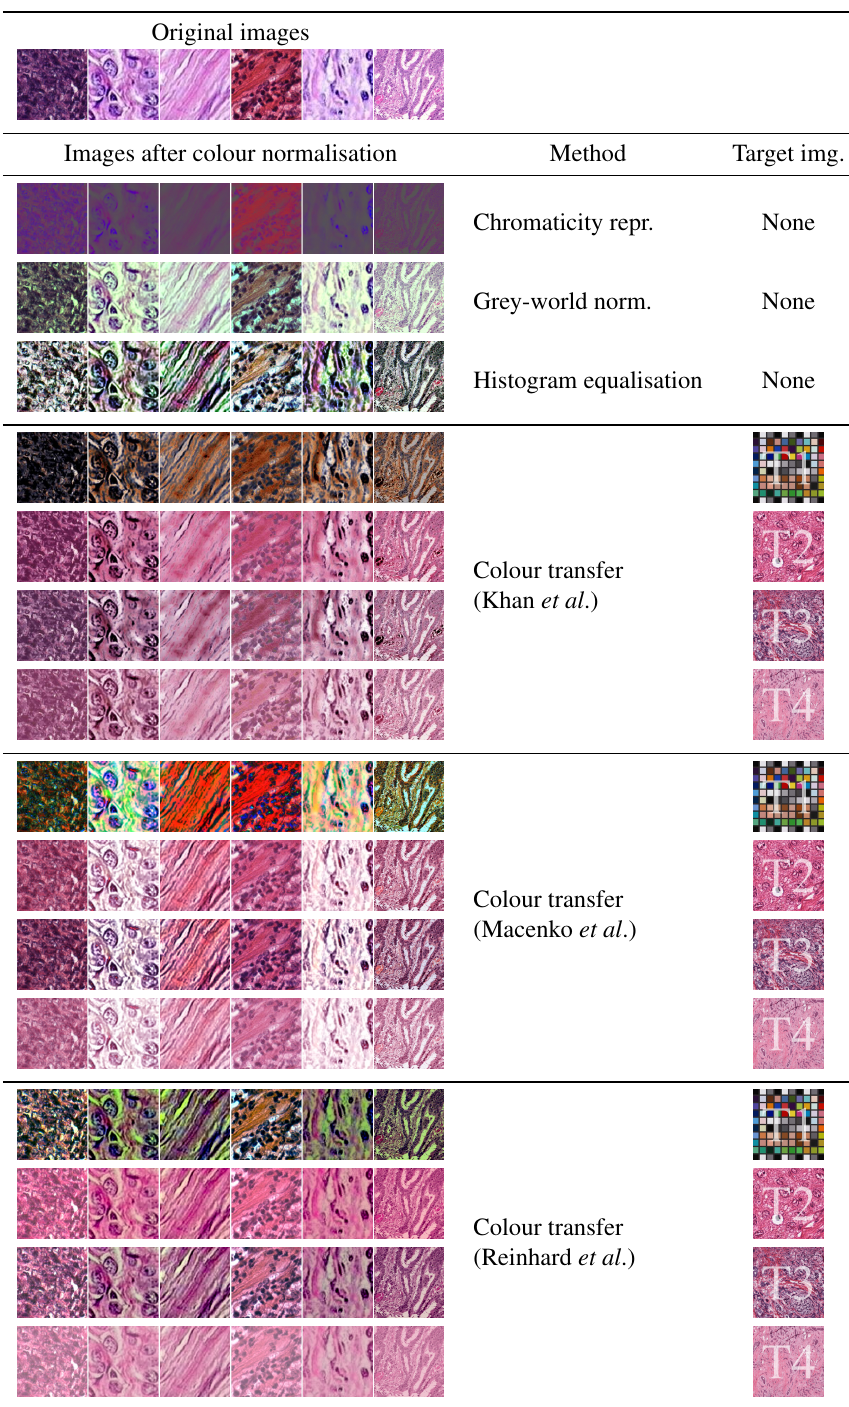
Figure 4. Illustration of the effects of color constancy and color transfer on a series of representative images with four different target images. Three targets are histological images, and one is a color checker mask used to investigate the impact caused by an image with a large and distant color